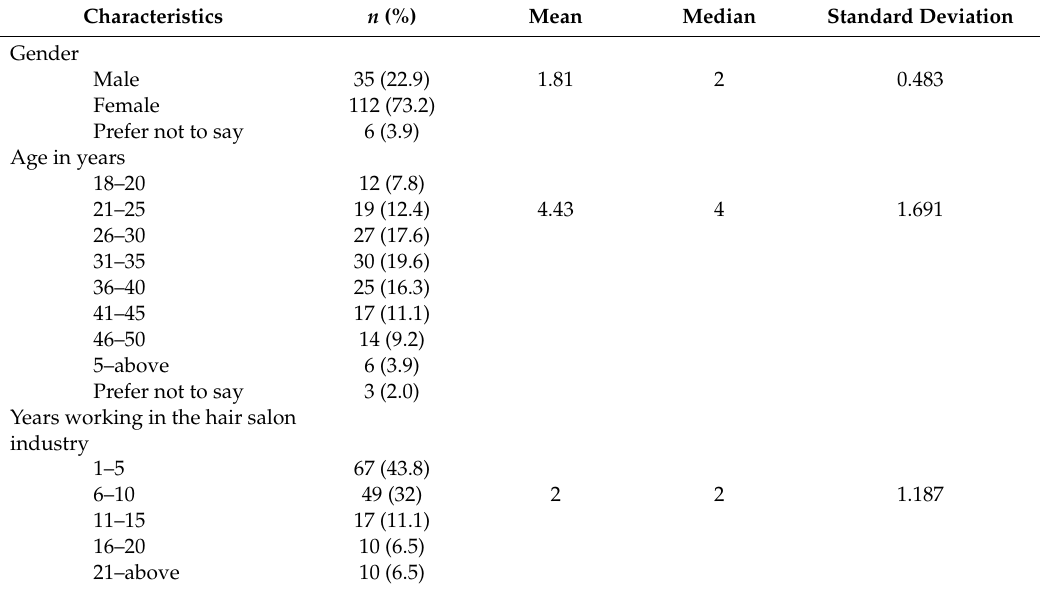
Table 1. Demographic characteristics for operators of hair